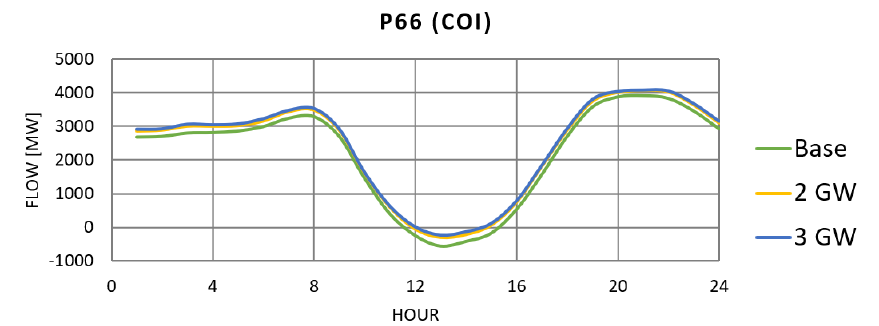
Figure 13. Impacts to daily hourly average flows for each hour of the year from OSW integration on Path 66, the transmission path along the I-5 interstate flowgate path traversing Oregon into northern California. Positive direction is flow south into